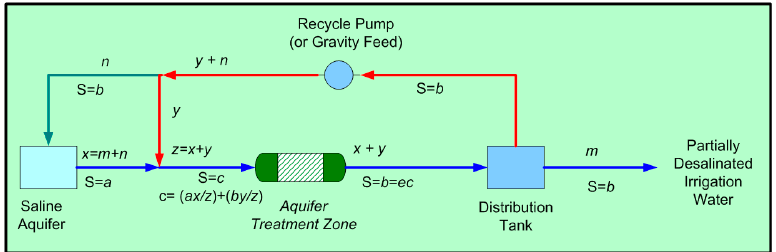
Figure 20. Process flow diagram for a schematic aquifer, which has been reconfigured as an Aquifer Treatment Zone with recycle ( Recycle Strategy ). S = salinity.